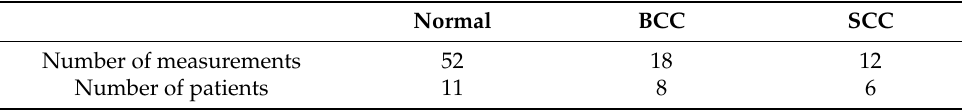
Table 1. Summary of samples’ pathological